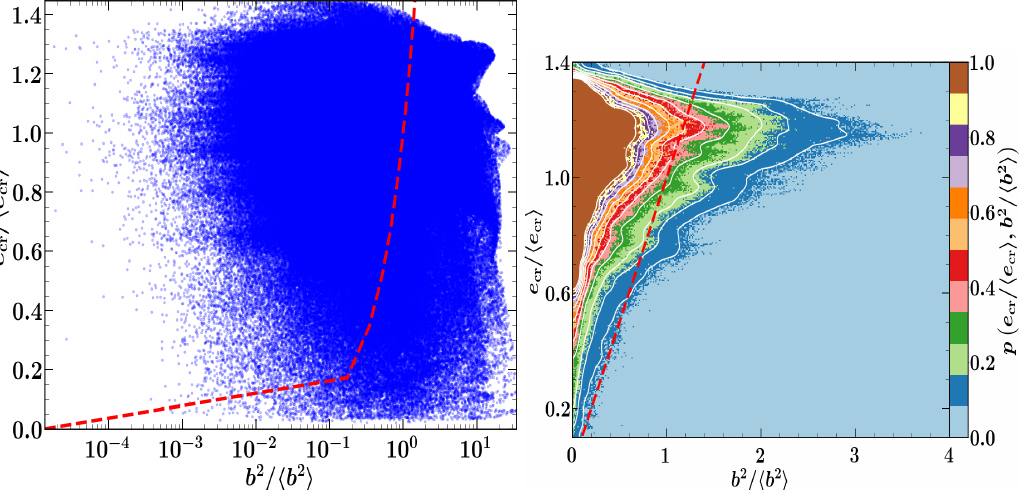
Figure 8. Left panel: Scatter plot for the normalized energy densities of cosmic rays e cr / (cid:104) e cr (cid:105) and magnetic fields b 2 / (cid:104) b 2 (cid:105) for the case with (cid:104) e cr (cid:105) ≈ (cid:104) b 2 (cid:105) at the box scale of a physical size 100 pc (parameters chosen to ensure the same). Right panel: Joint PDF of e cr / (cid:104) e cr (cid:105) and b 2 / (cid:104) b 2 (cid:105) with contours showing probability levels [ 0.1,0.15,0.2,0.3,0.4,0.5,0.6,0.7,0.8,0.9,0.99 ] for a range in cosmic ray number density ( 0.1 ≤ e cr / (cid:104) e cr (cid:105) ≤ 1.4 ) and magnetic field energy density ( 0.0 ≤ b 2 / (cid:104) b 2 (cid:105) ≤ 4.0 ) where most points ( ≈ 95%) of the left-hand panel lie. The red dashed line shows the perfect correlation between two quantities in both panels (note the semi-log scale in the left-hand panel). Even though both energy densities are equal when averaged over the size of the domain, locally, they are